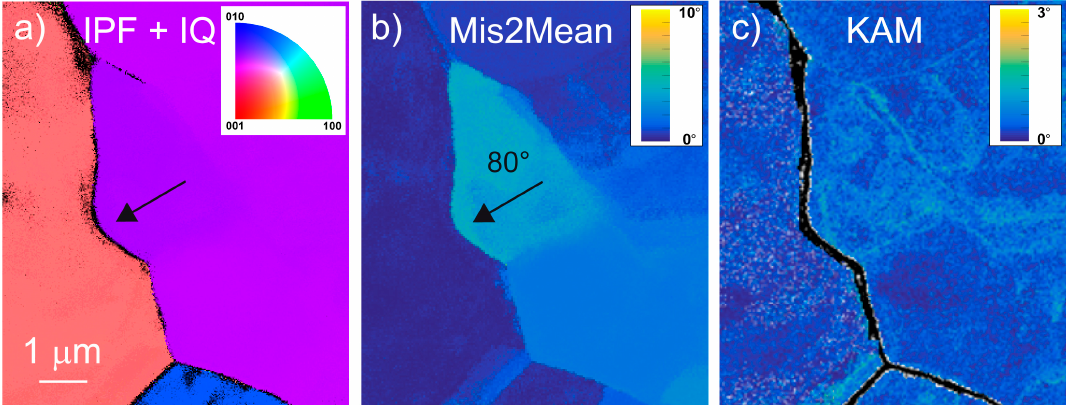
Figure 5. M642 GB. ( a ) IPF corresponding to the direction perpendicular to the plane of view superimposed with the IQ (Equation (1)); color code inserted ( Pnma ). The GB arrow in black has a misorientation of 80°. ( b ) Mis2Mean map corresponding to ( a ), up to 10 °. ( c ) KAM map corresponding to ( a ), up to 3°.